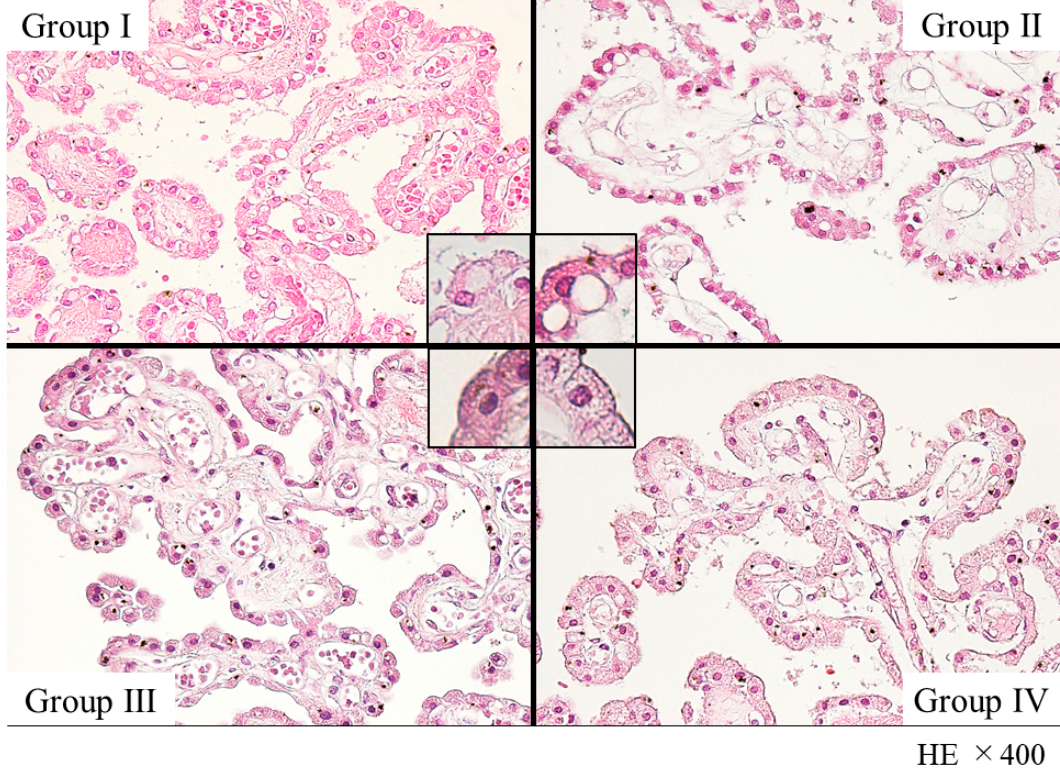
Figure 4. The histopathological findings of choroid plexus epithelial cells in autopsy cases in each group (H&E staining 400×). Cytoplasmic vacuolations are seen. In particular, more than 10% of choroid plexus epithelial cells have cytoplasmic vacuolations in Groups I (27.5%) and II (13.6%), with 9.2% in Group III and 2.1% in Group IV.